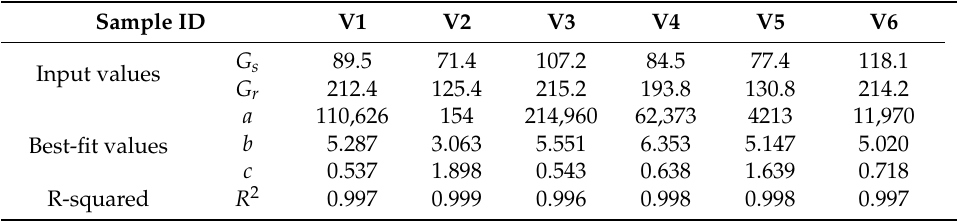
Figure 12. WGCCs of six loess samples collected from different regions. Table 5. The results of model fitting to experimental data for six different loess samples.